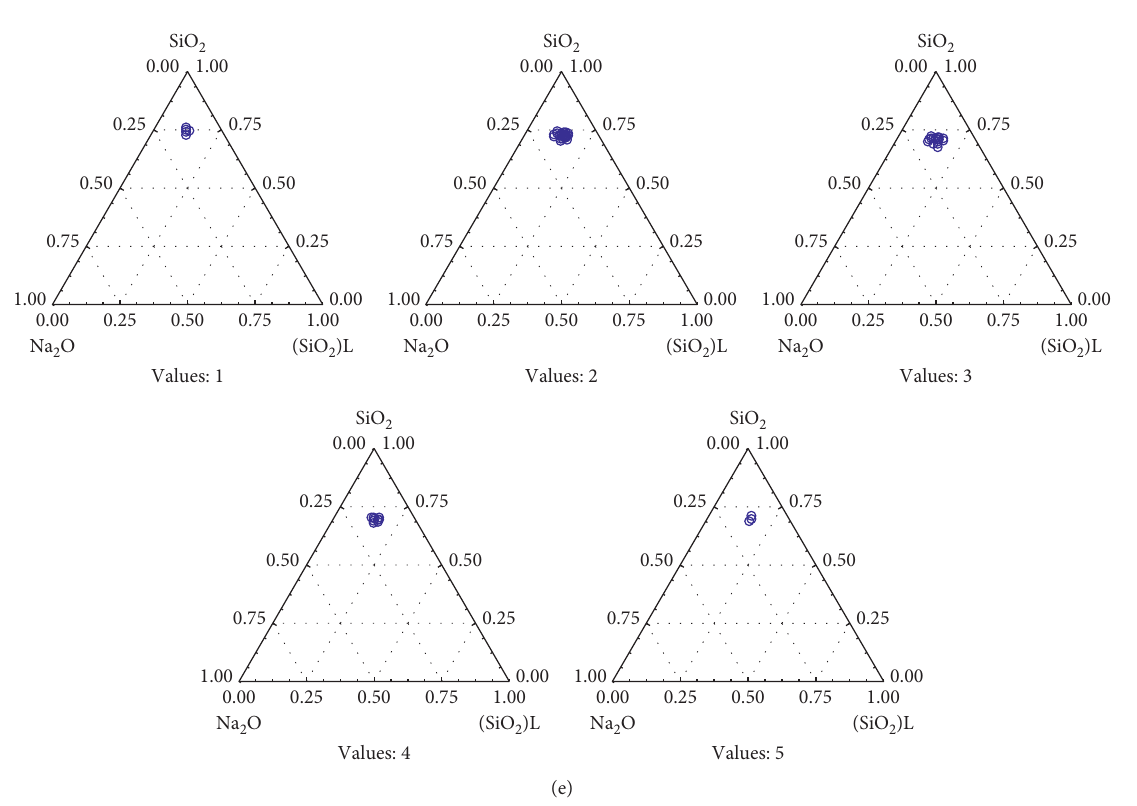
Figure 5: Ternary plot of the molar composition with respect to the compressive strength (values: 1 � 0–10 MPa; 2 � 10–20MPa; 3 � 20–30MPa; 4 � 30–40MPa; 5 � 40–50 MPa). Table 6: Weight matrix and bias value of the output